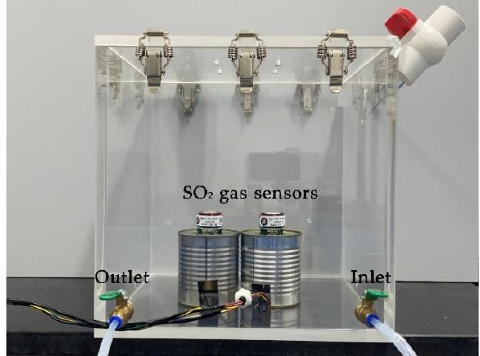
Figure 6. SO 2 electrochemical gas sensor test chamber.